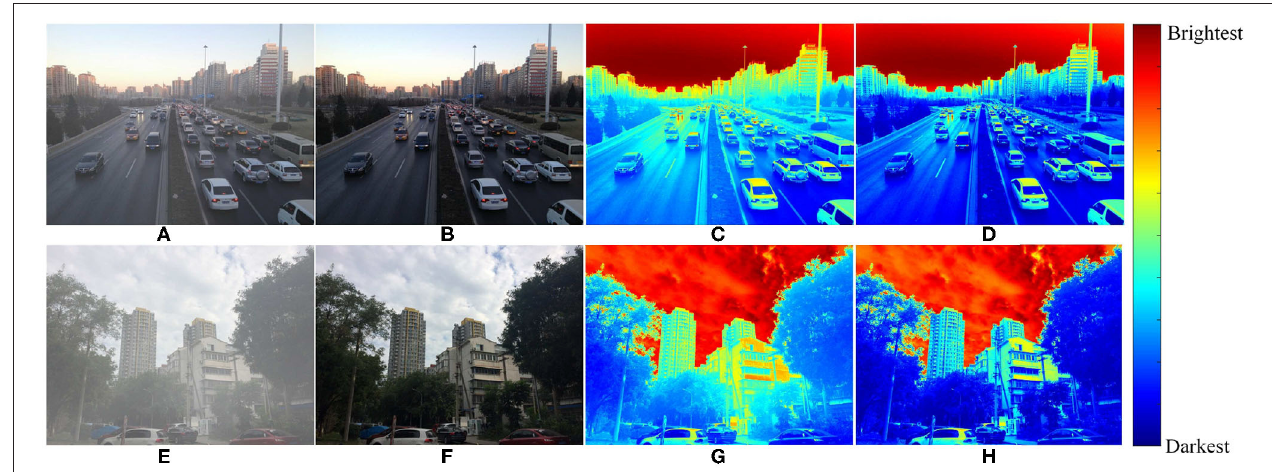
FIGURE 1 | Foggy and fog-free images and their heat maps. (C,G) Represent the heat maps of foggy images (A,E) , respectively. (D,H) Represent the heat maps of fog-free images (B,F) ,